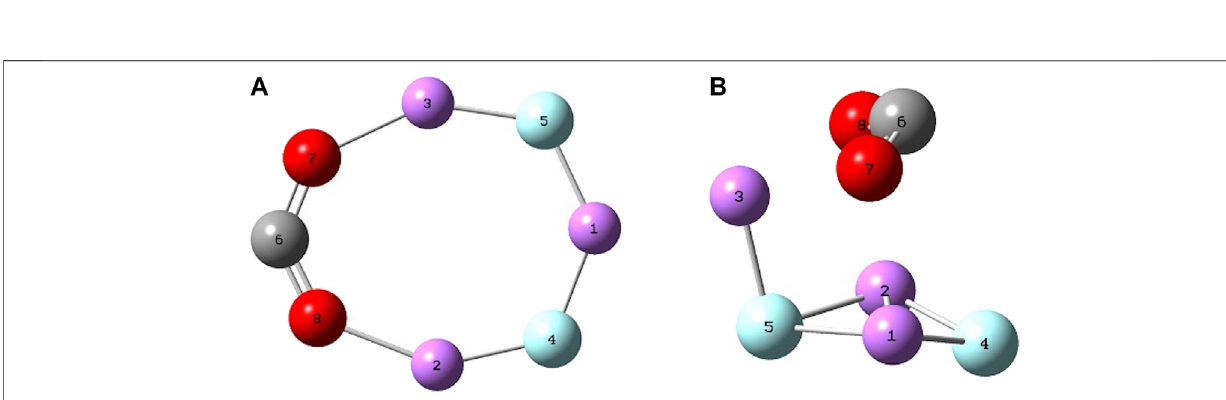
FIGURE 2 | B3LYP/6-31G* optimized geometries of (A) Li 3 F 2 (C 2v ), and (B) Li 3 F 2 (D 3h ) reducing CO 2 .